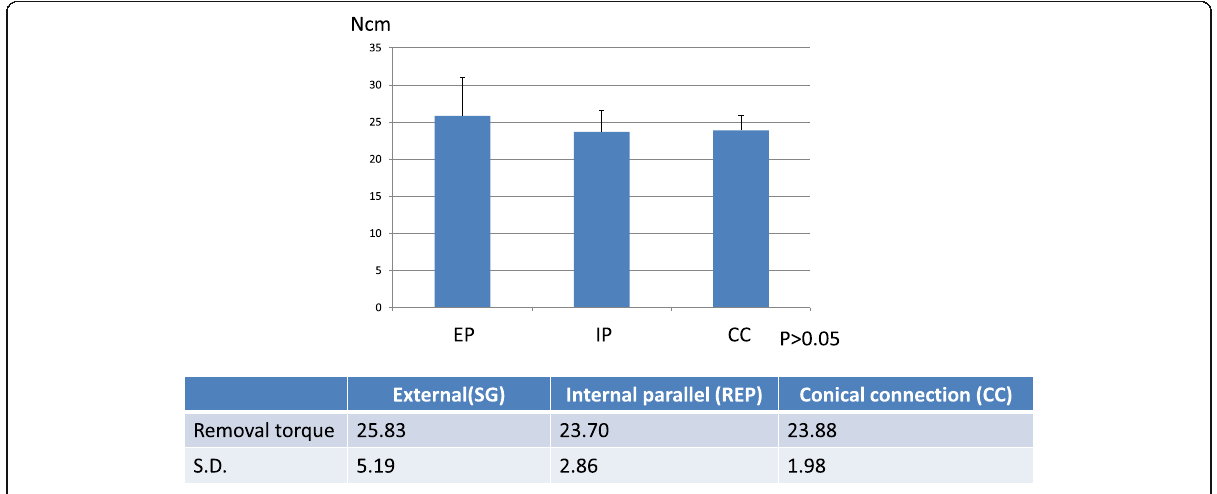
Fig. 2 Removal torque of abutment screw after 2000-cycle